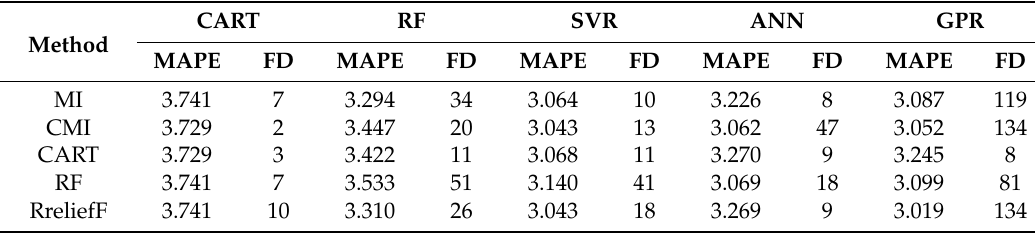
Table 5. Optimal feature subset construction of 1:00 with different methods for New England.